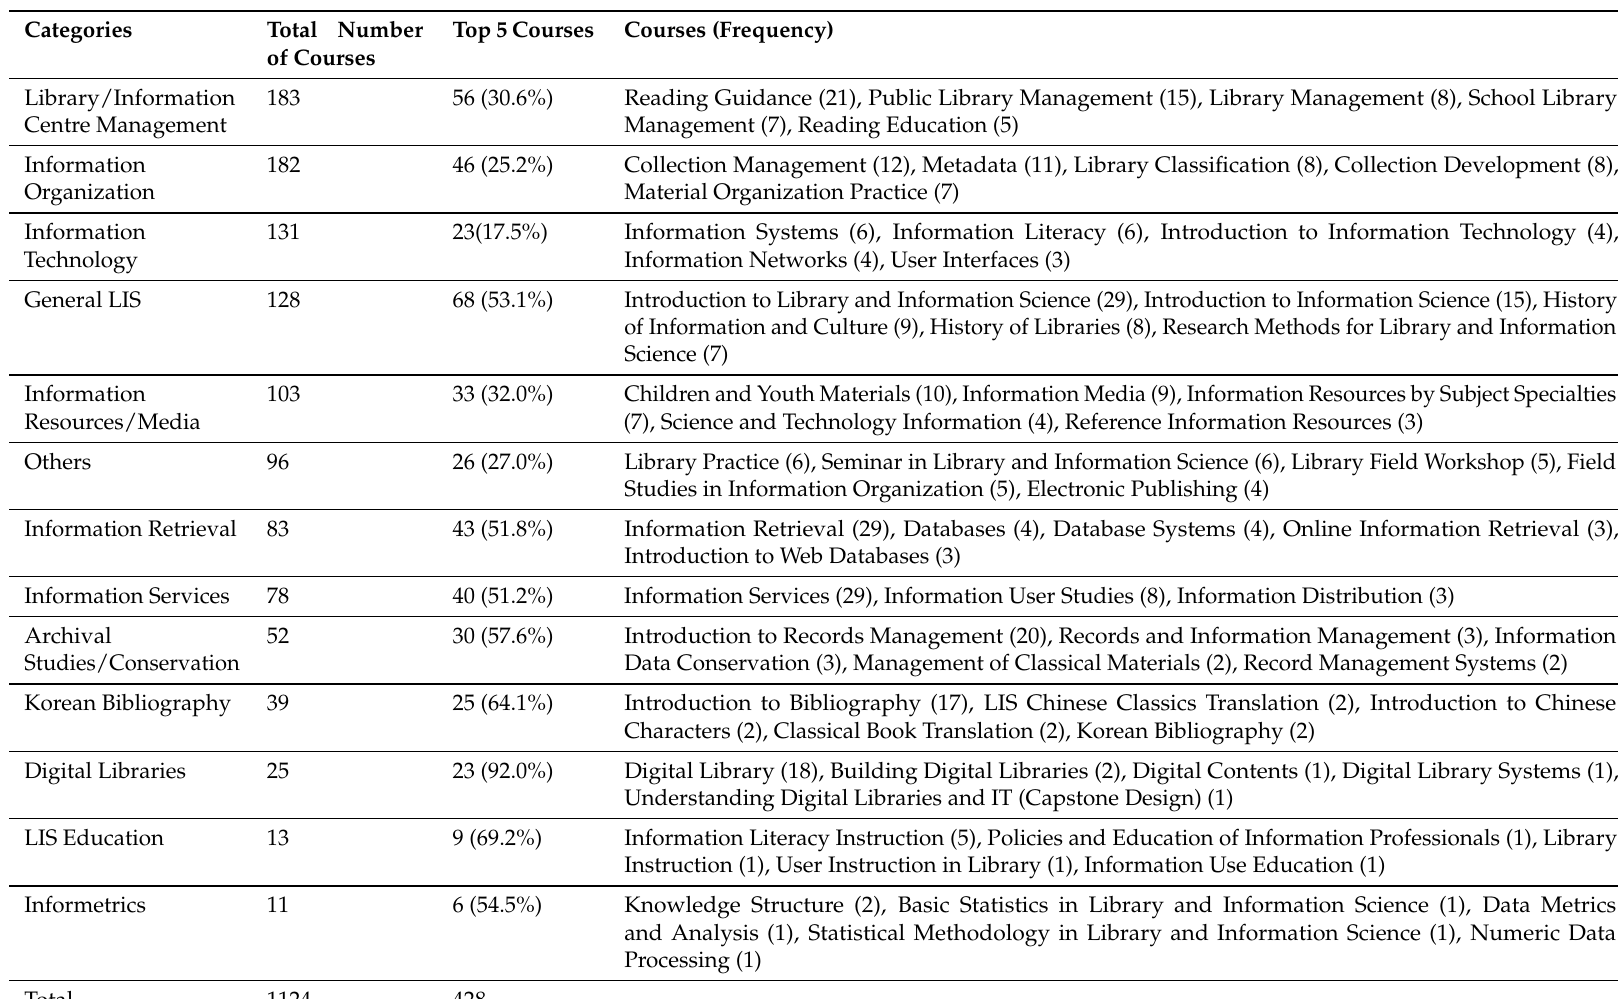
Table 2. Top five established courses, by categories, with their